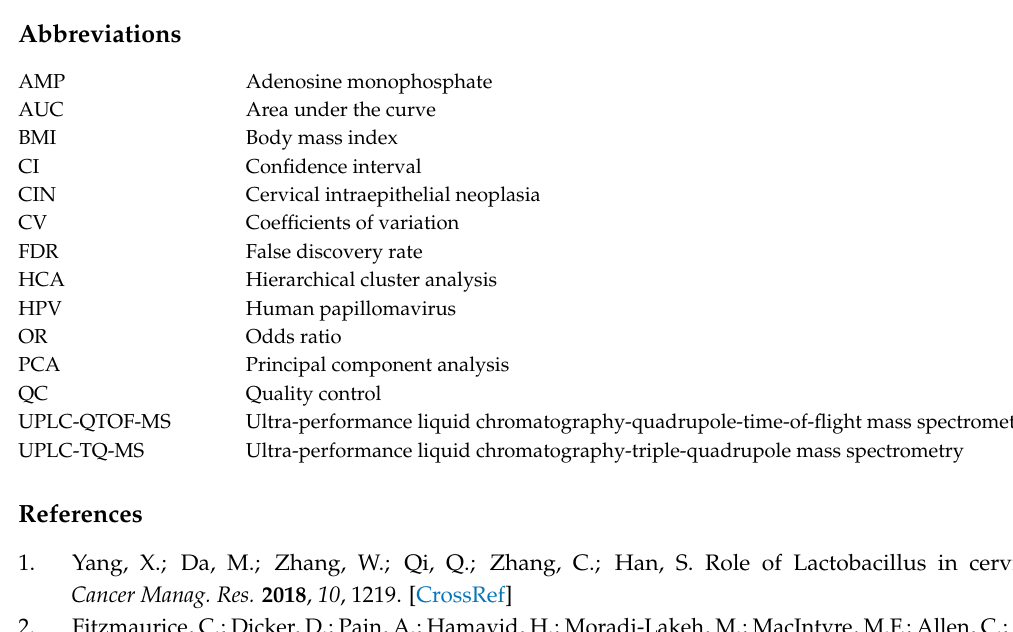
Figure S1: PCA score plots with QC clusters, Figure S2: Construction of the altered metabolism pathways using MetPA, Figure S3: HCA results (a. positive, b. negative mode), Figure S4: Construction of altered metabolic pathways using MetPA analysis for targeted metabolites, Figure S5: Alanine, aspartate, and glutamate metabolism (C00049: Asparate, C00025: Glutamate). Table S1: Retention times and multiple reaction monitoring transitions of plasma metabolites quantified by UPLC-TQ-MS, Table S2: AUC values of significantly altered metabolites ( p value < 0.05) in given HCA